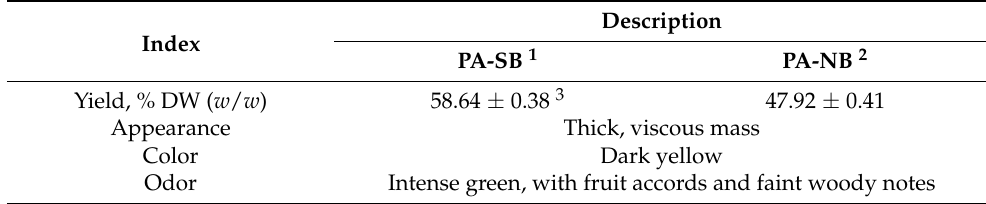
Table 7. Characteristics of dry ethanolic extracts obtained from Physalis alkekengi